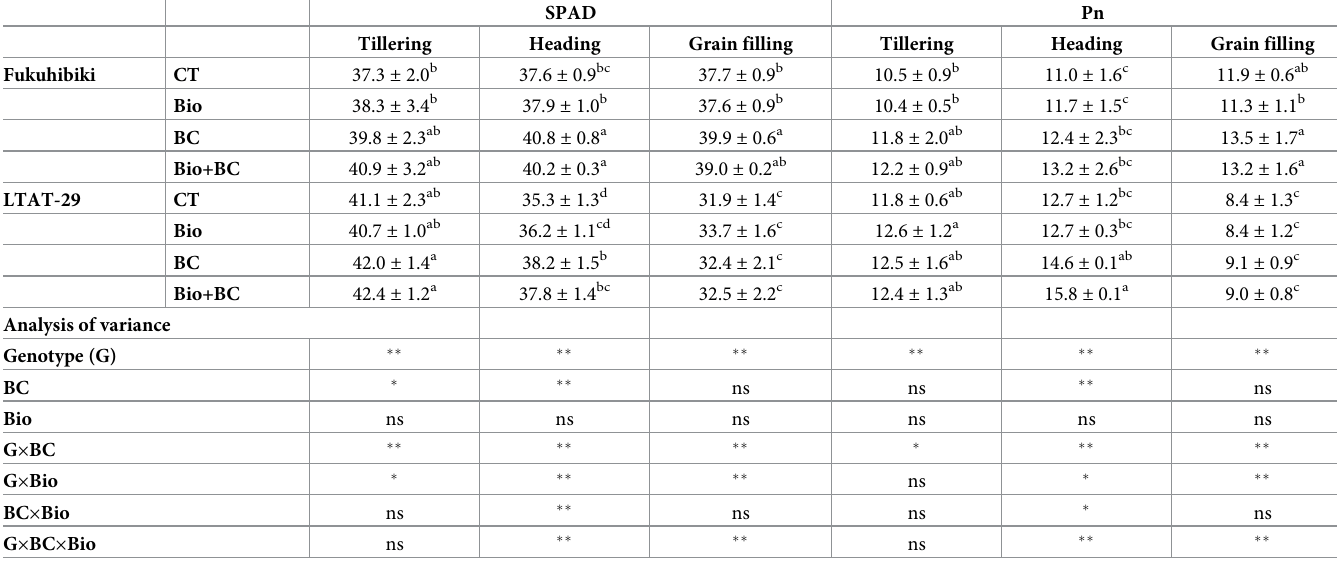
Mean ± SD followed by the same letter are not statistically significant using Fisher’s LSD test (p < 0.05). � p < 0.05 �� p <